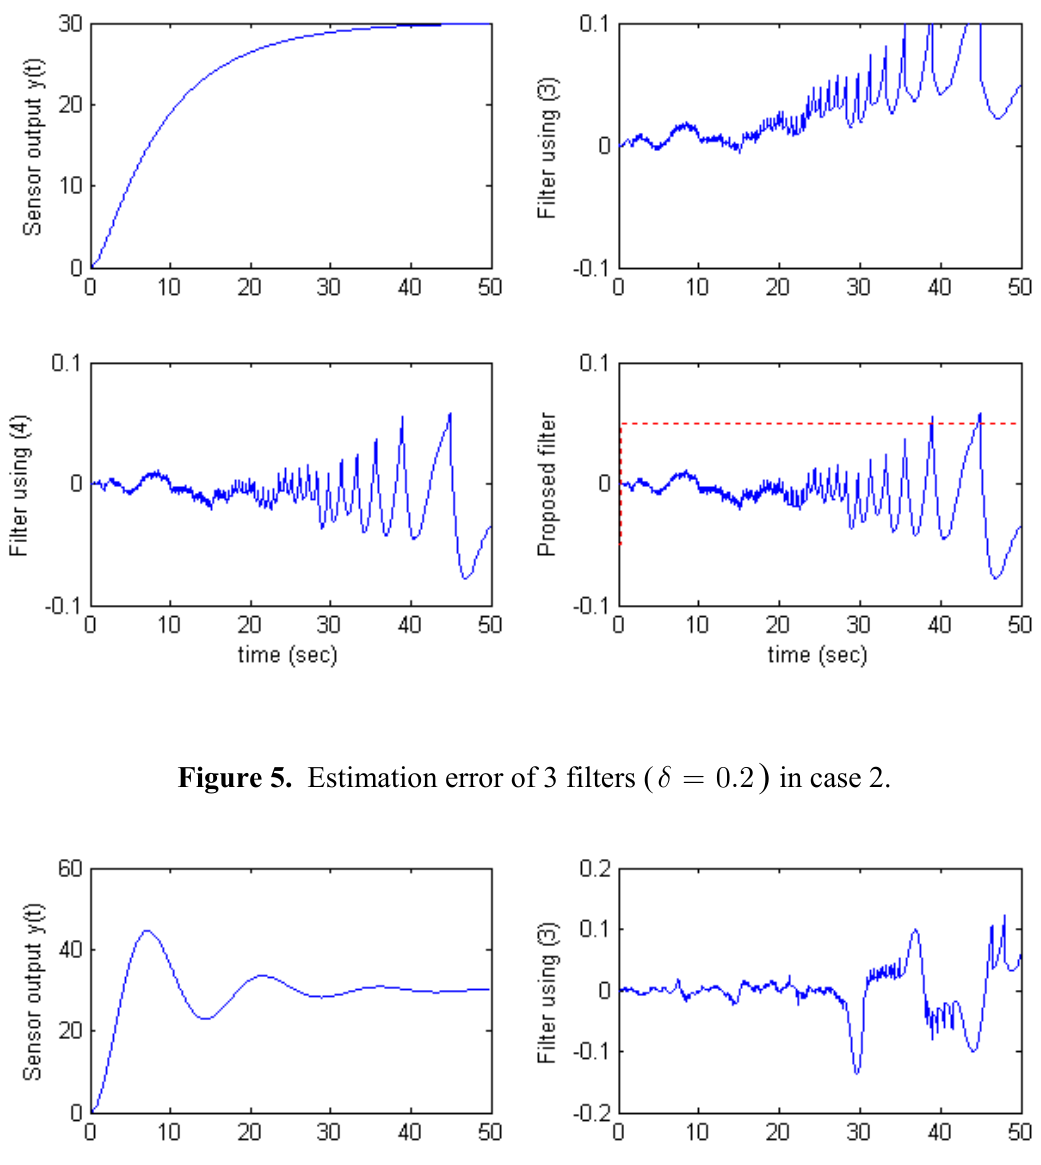
Figure 4. Estimation error of 3 filters ( 0.2 δ = ) in case 1. The solid line on the proposed filter graphs presents the sign of Selector in (7).